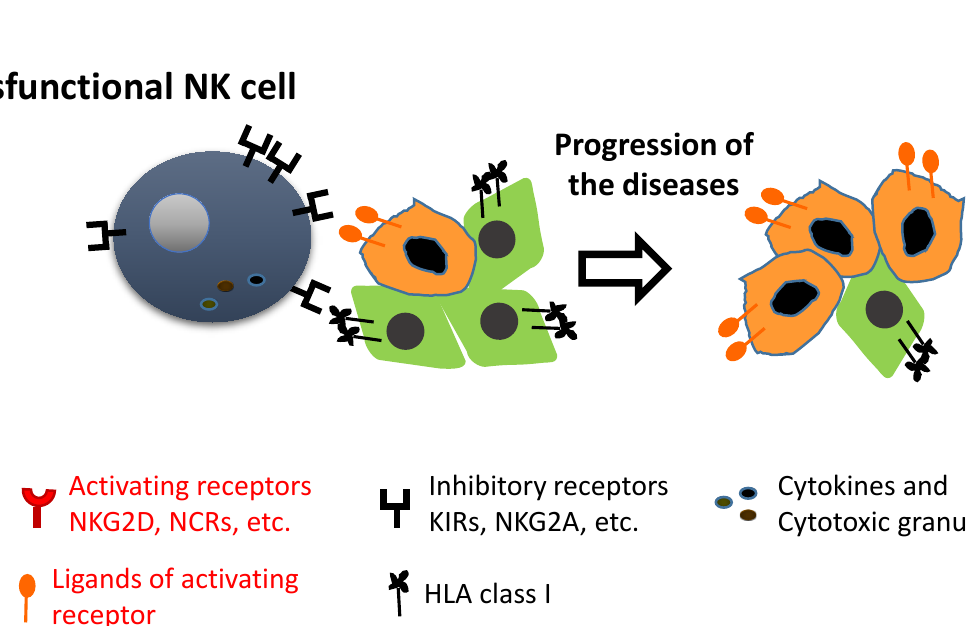
Figure 1. Schematic depiction of NK cell immunosurveillance of cancer and viral infections. ( A ): Healthy NK cells expressing activating receptors can recognize virus- infected cells and cancer cells, and release sufficient amount of cytotoxic granules and cytokines to kill and clear virus-infected cells and cancer cells. ( B ): Dysfunctional NK cells expressing an imbalance of activating and inhibitory receptors with high expression of inhibitory receptors, malfunctions in the recognition of cancer and virus-infected cells and the release of cytotoxic granules and cytokines to kill them, evasion of immunosurveillance of viral infections and cancer, and the spread of viral infections and progression of